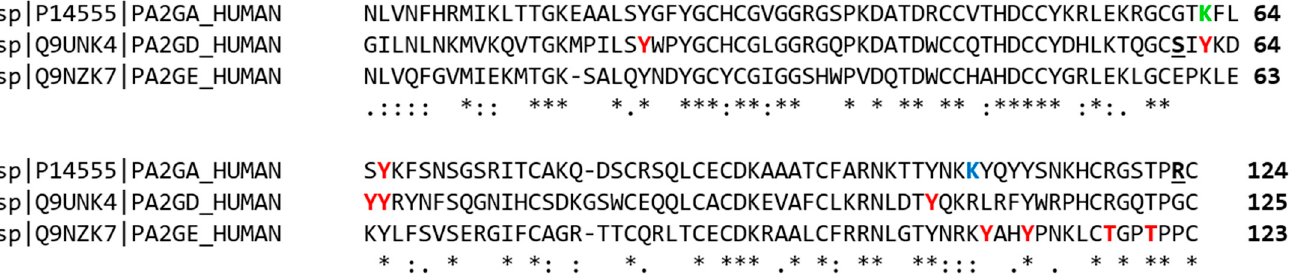
Figure 2. PTM sites and pathological genetic variants of human sPLA2s of group II. High throughput studies of PTMs identified, in these proteins, phosphorylation sites (in red), a ubiquitination site (in green), and a sumoylation site (in blue). Residues mutated in genetic diseases are evidenced in underlined bold. The asterisks indicate fully conserved residues, the colons conservation of amino acids with strong similar properties, while the symbol “.” indicates conservation of amino acids with weakly similar properties.